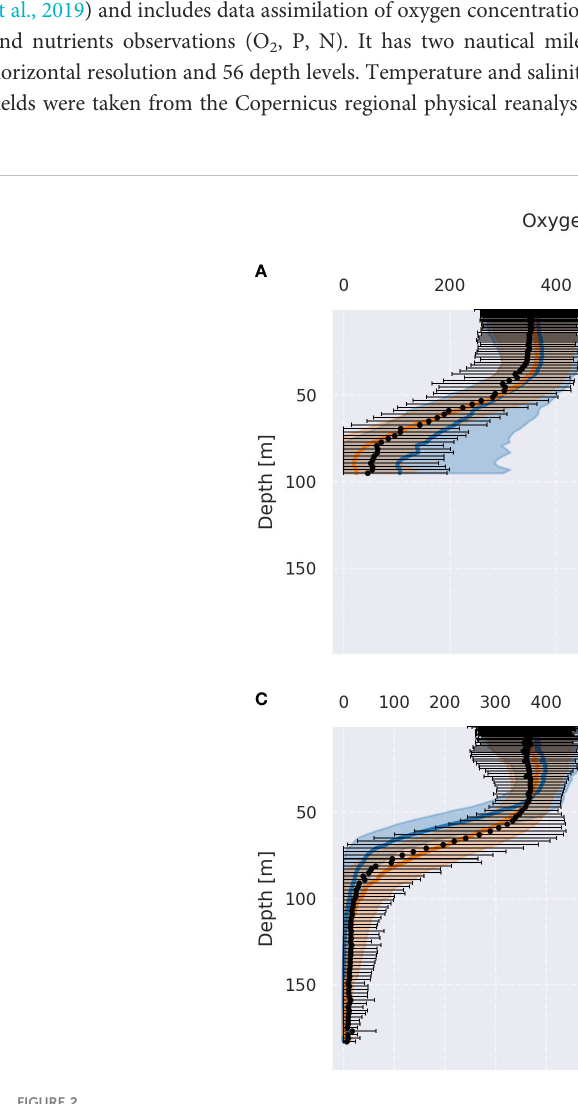
FIGURE 2 Climatological mean oxygen pro fi les (averaged from 1948 to 2018) for all sub-basins studied [Bornholm Basin (A) , eastern Gotland Basin (B) , northern Gotland Basin (C) , and western Gotland Basin (D) ]. Colored translucent and black hatched areas for model data and observations, respectively, show the variability (+- 2